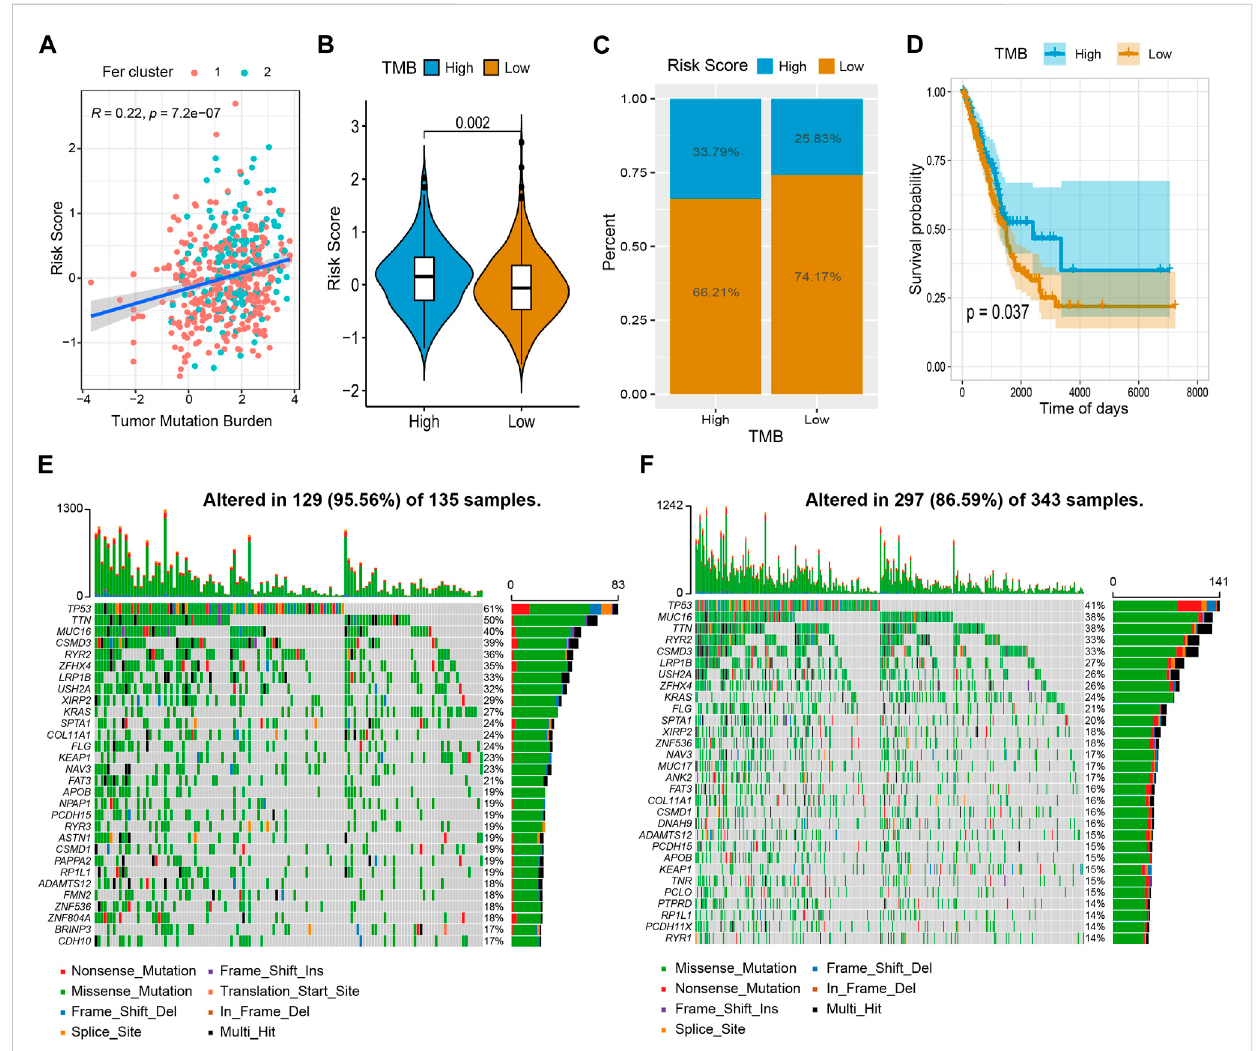
FIGURE 9 The relationship between tumor risk score and tumor mutation burden. (A) The risk score was positively correlated to TMB. (B,C) Violin chart and proportional distribution bar chart showed that TMB was higher in the high-risk score group than in the low-risk score group. (D) The survival